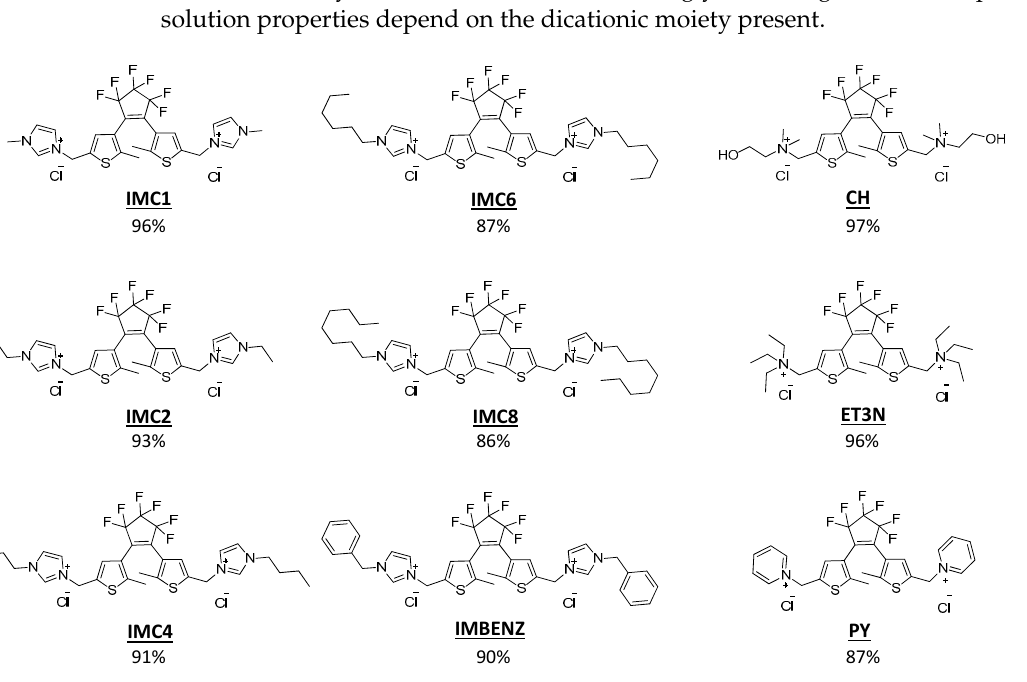
Figure 1. Chemical structure of synthesized GDILs.